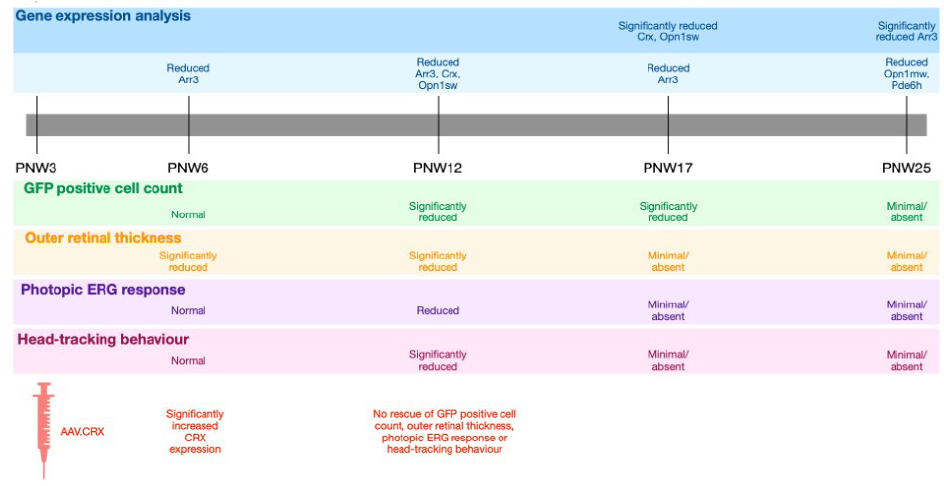
Figure 7. Summary of the changes in gene expression and phenotype over time in Rho −/− , OPN1-GFP